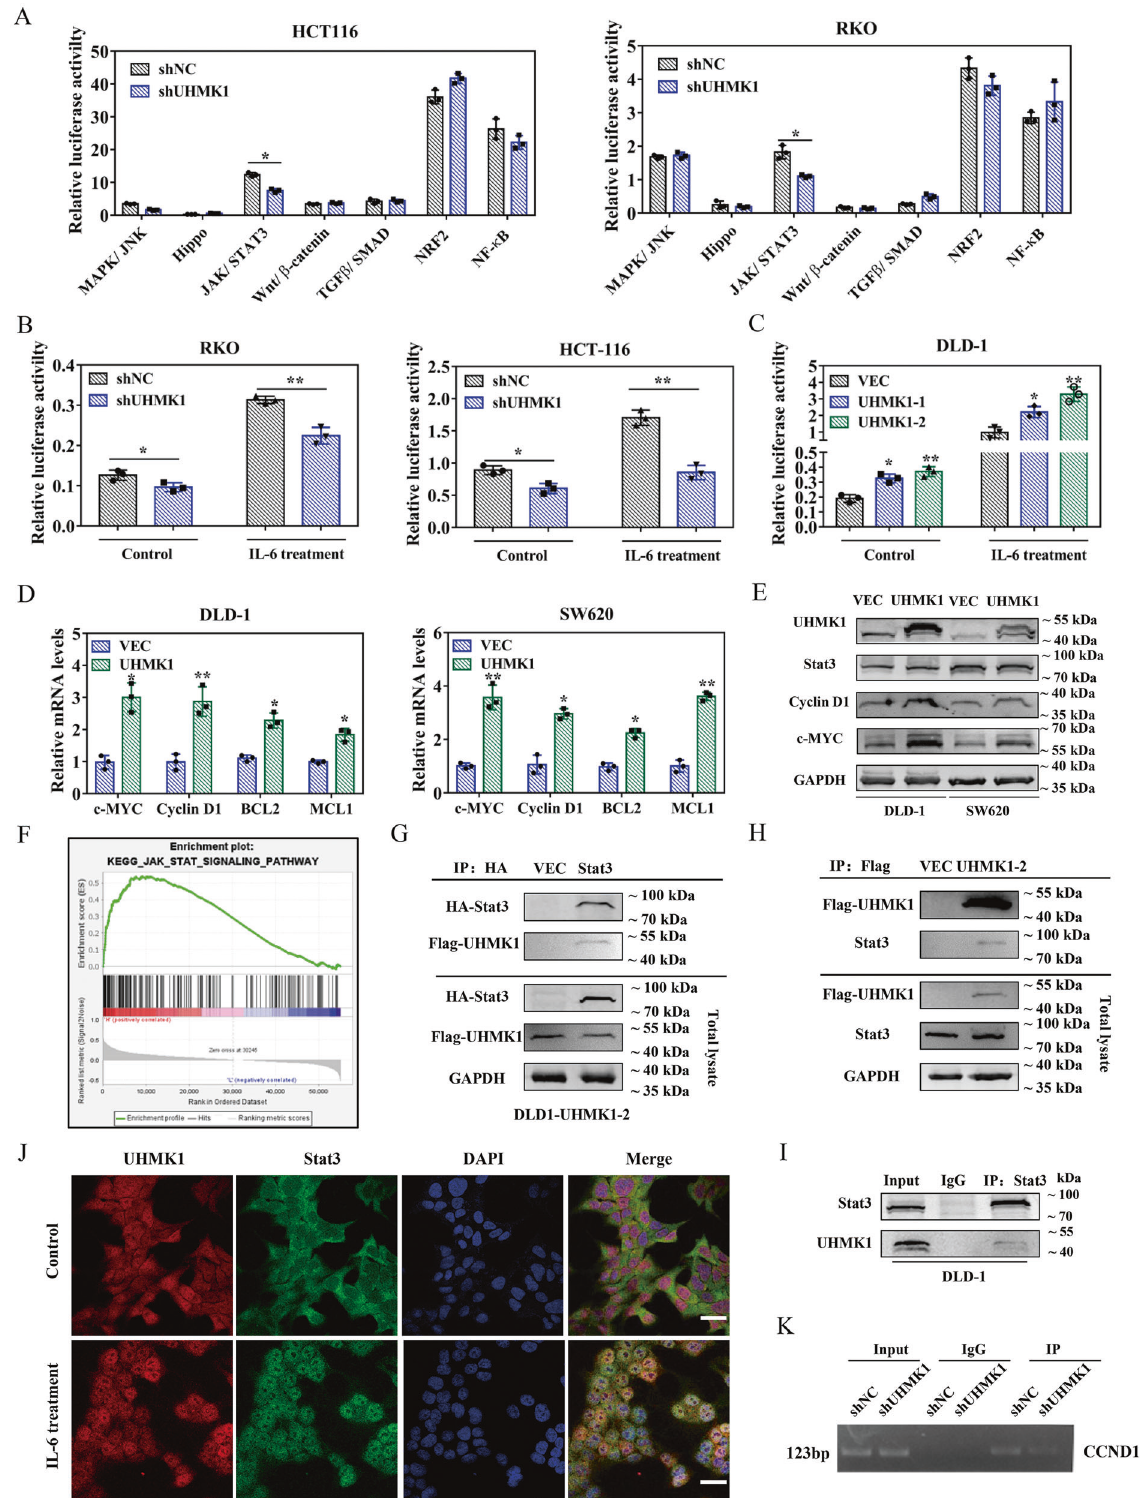
cells were then treated with oxaliplatin followed by colony formation assay. The results showed that overexpression of UHMK1 enhanced the resistance of DLD-1 cells to oxaliplatin (Fig. 3E). Flow cytometric analysis was used to investigate whether UHMK1 overexpression affects oxaliplatin-induced apoptosis. Compared with the control group, DLD-1/UHMK1-2 cells showed